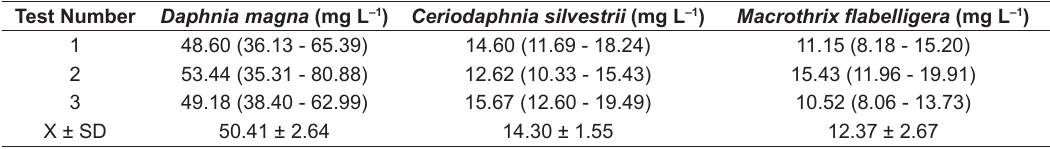
) from the present study and from literature for some species of Cladocera ex- 50